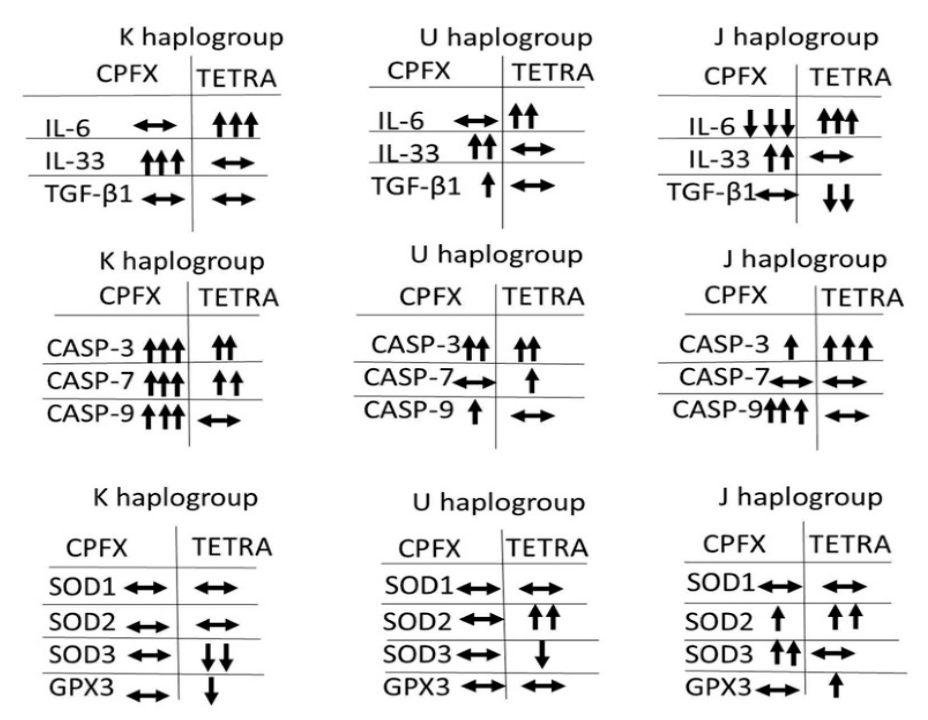
Figure 6. The Summary of Changes in Gene Expression Influenced by CPFX and TETRA Treatment Compared to Vehicle-Control Cells.